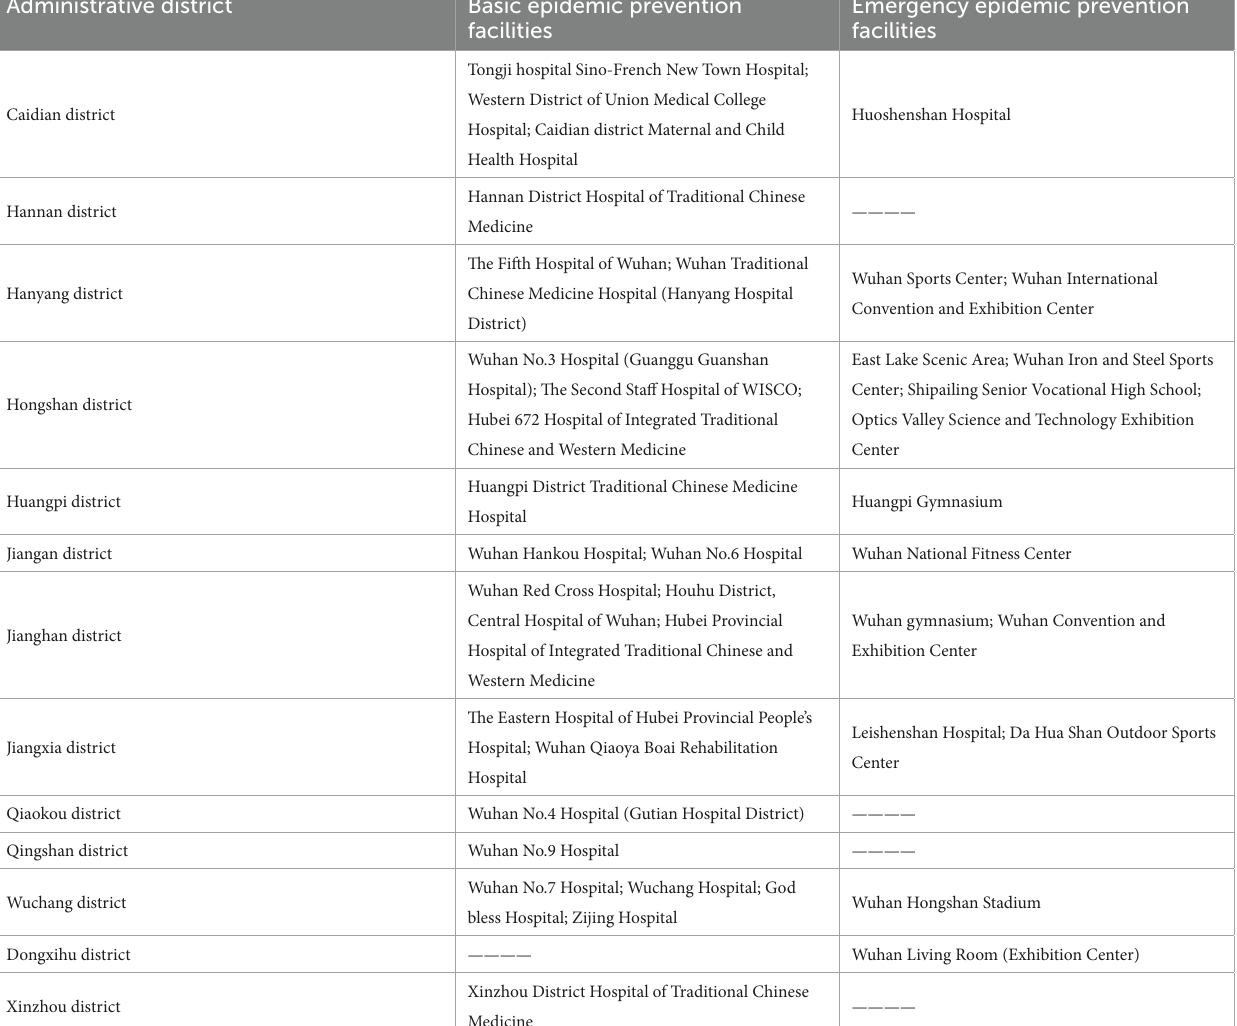
TABLE 1 Information on epidemic prevention facilities in 13 administrative regions of